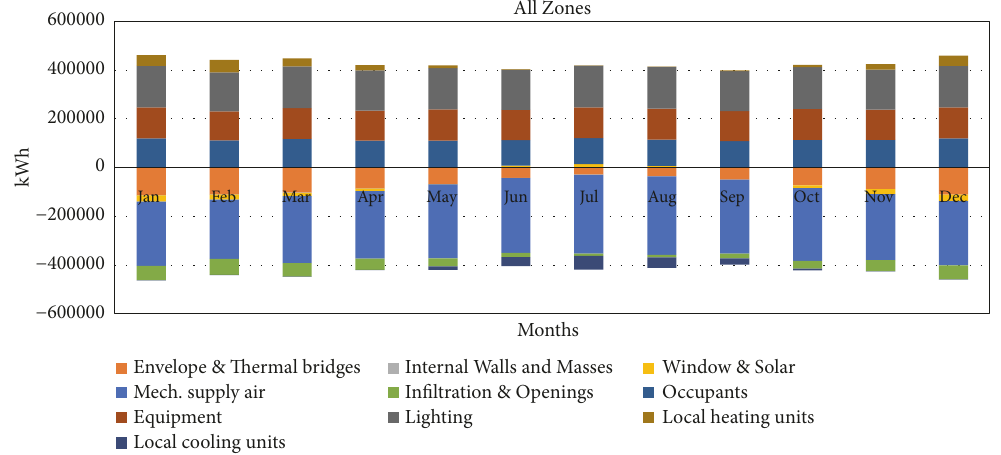
Figure 11: Results for building heat balance.